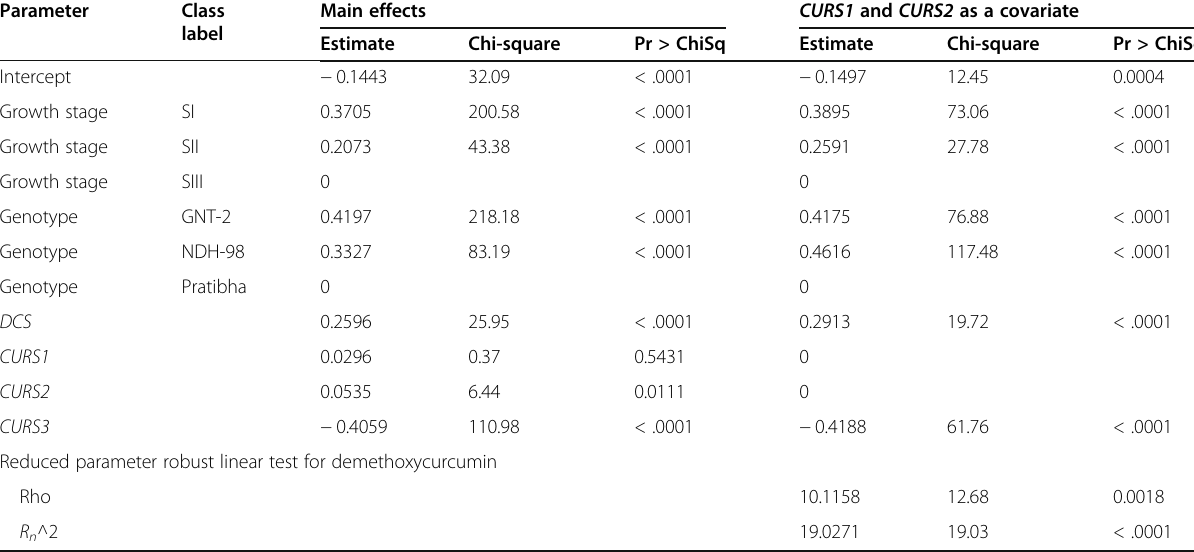
Table 4 Association-based test of DCS and multiple curcumin synthases with demethoxycurcumin Parameter